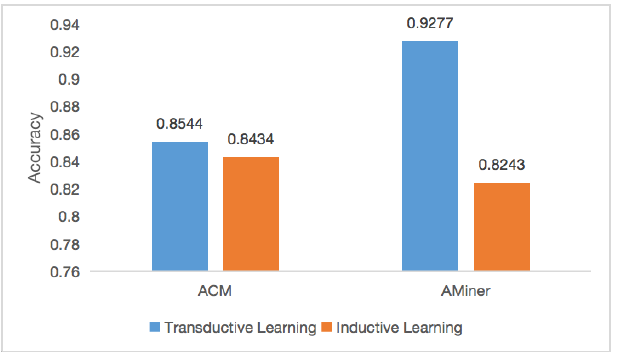
Figure 5. The experimental result of the inductive learning task. The accuracy is little lower than that of the MSGCN